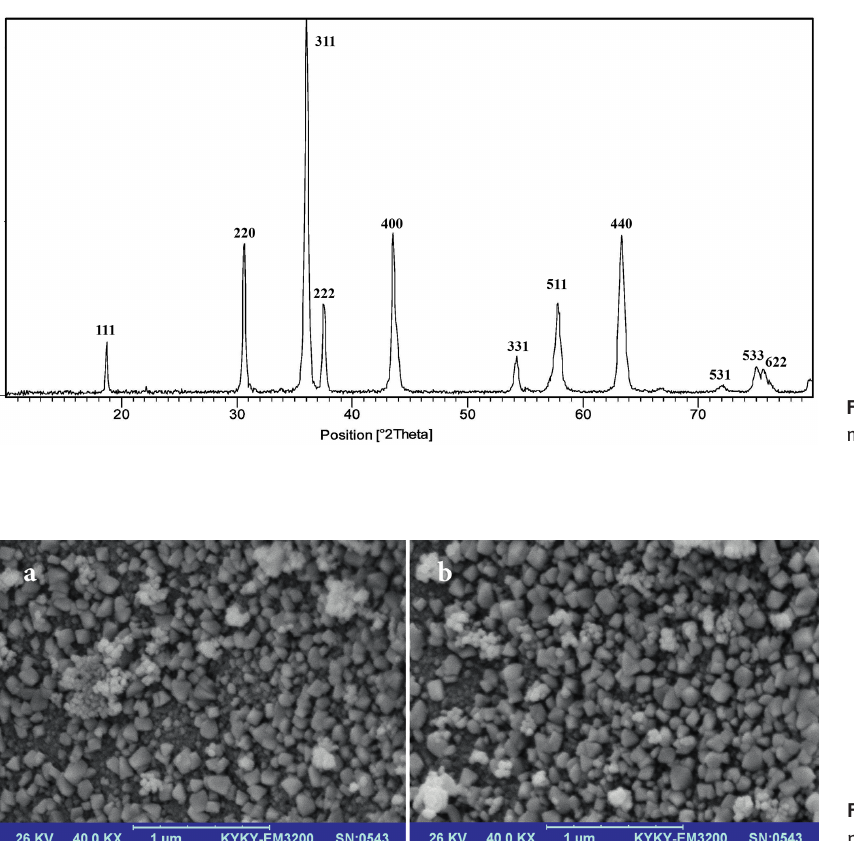
Figure 3: SEM images of FeAl 2 O 4